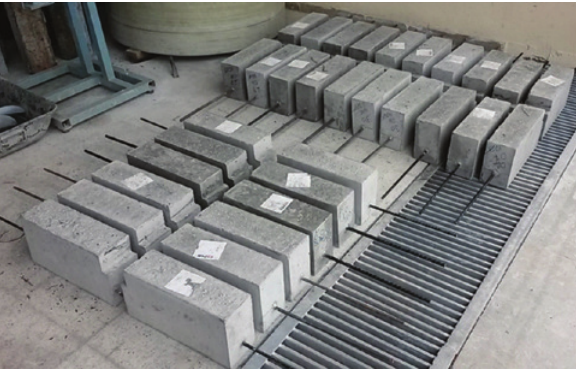
Figure 7: A view of hinged beams prepared for the bond test.